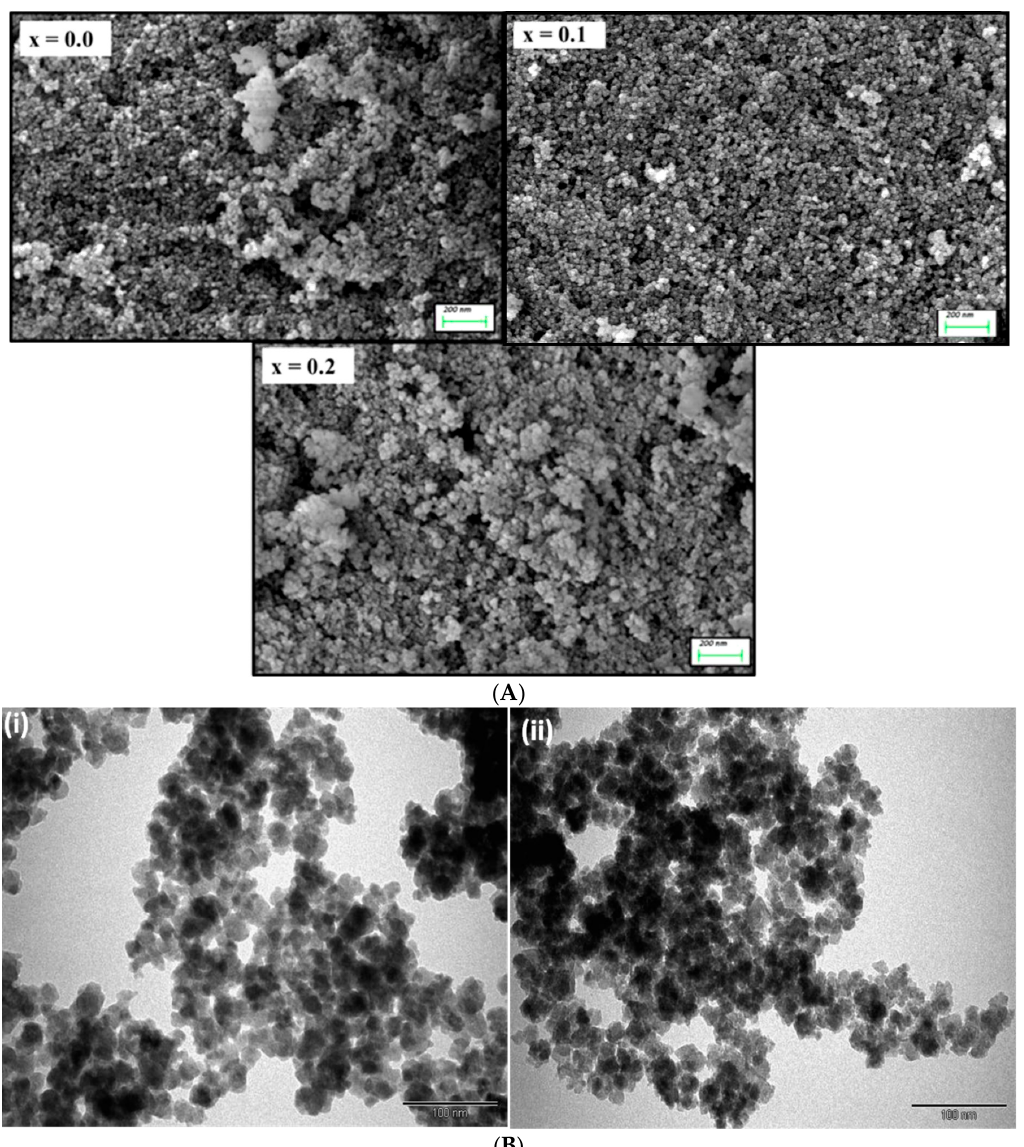
Figure 2. ( A ) FE-SEM of CoNd x Fe 2 − x O 4 (0.0 ≤ x ≤ 0.2) NPs; ( B ) TEM images of (i) CoFe 2 O 4 (x = 0.0), (ii) CoNd 0.2 Fe 1.8 O 4 (x = 0.2) NPs.